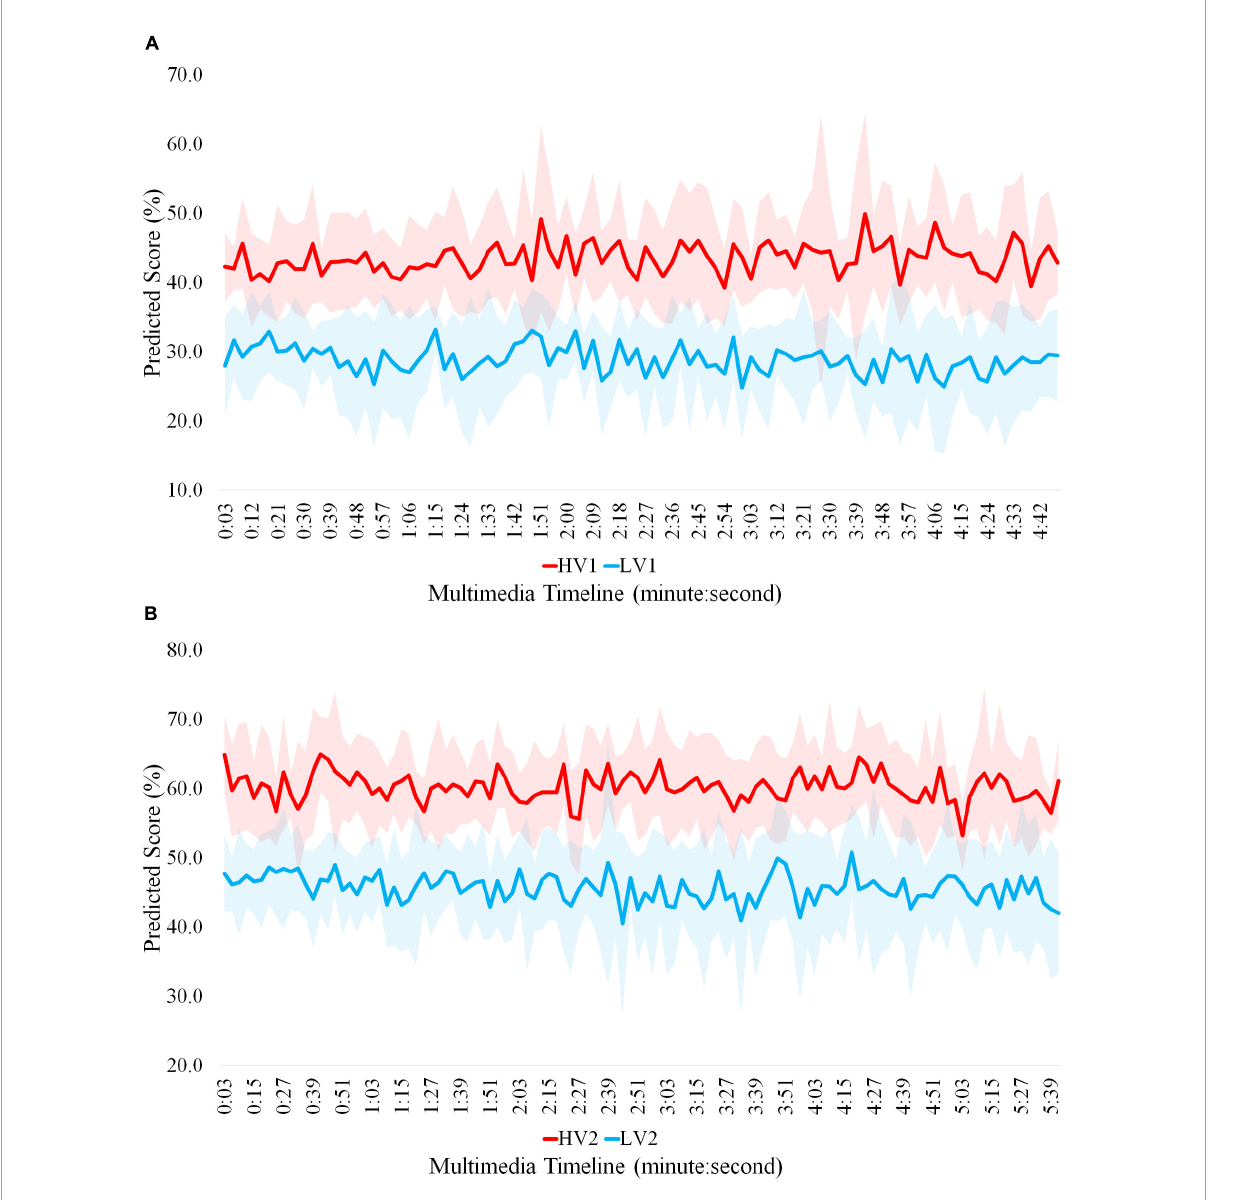
FIGURE8 Predicted cognitive load scores in (A) multimedia 1 and (B) multimedia 2 over